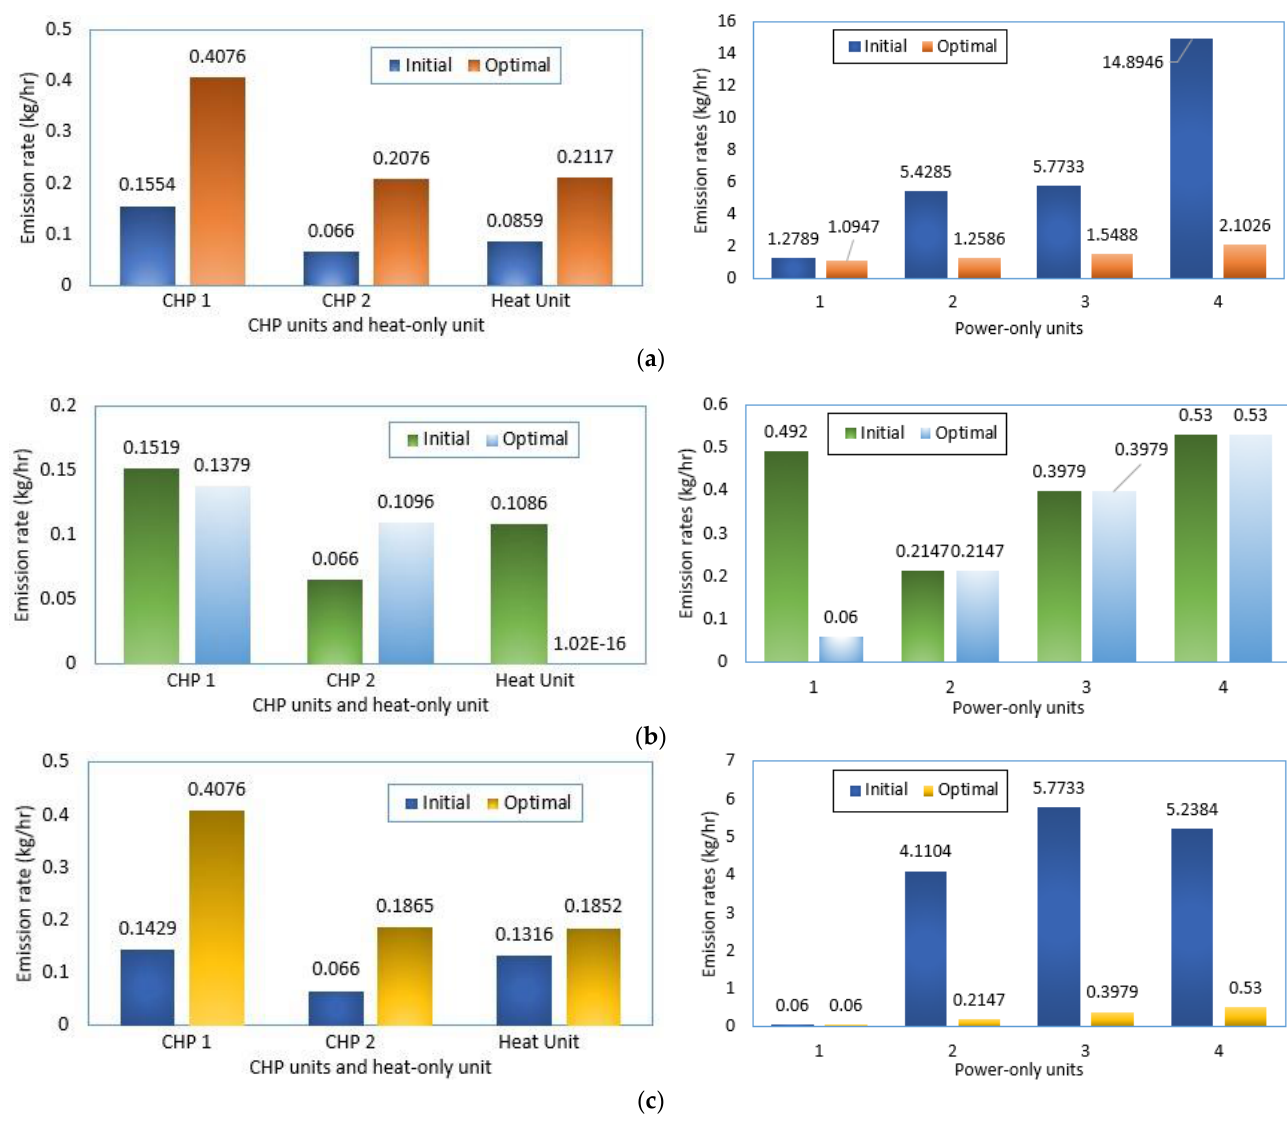
Figure 10. Emission rates of all the units of Case 3 for the three loading levels. ( a ) First Loading Level; ( b ) Second Loading Level; ( c ) Third Loading Level.